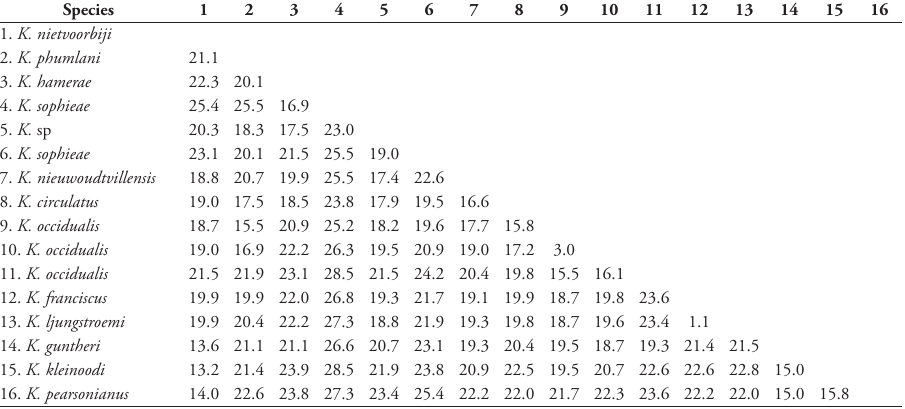
Table 2. Pairwise p genetic distances (%) between the investigated Kazimierzus species/lineages.